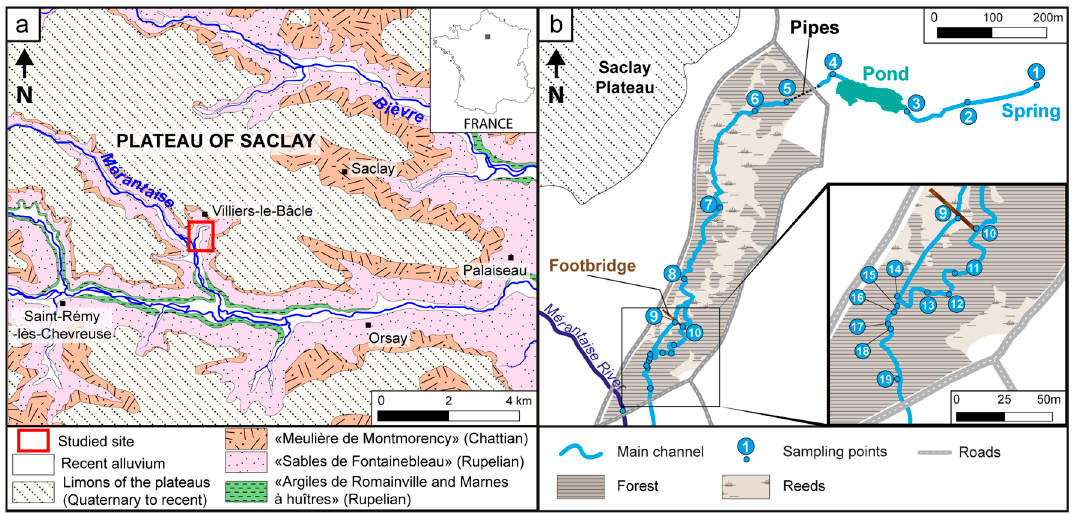
Figure 1. ( a ) Geographic location of the tributary of the Mérantaise River and regional geological map; ( b ) Detail of the studied stream from the spring to the confluence with Mérantaise with the location of sampling points (1 to 19).